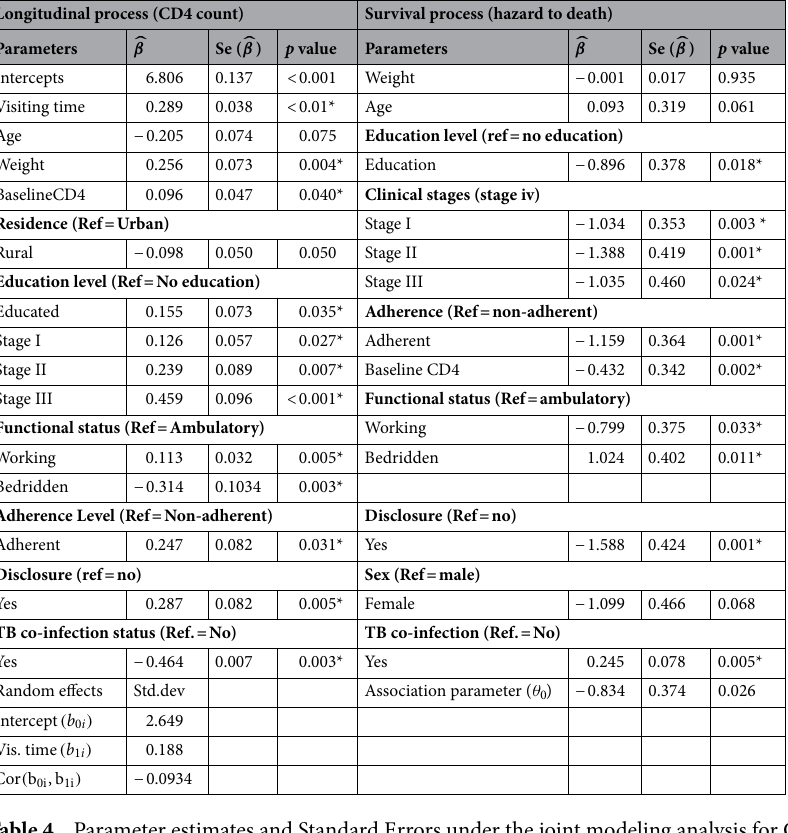
Hence, The rate of hazard for the death of educated family children was decreased by 61.2% (1–0.388)*100 as compared with non-educated family children, keeping the other covariates constant (HR = 0.388, 95% CI (0.185, 0.817), p value = 0.013). As baseline CD4 cell count increased by one cell/mm3, the rate of hazard/risk for death was decreased by 2.1% , keeping the other covariates constant (HR = 0.979, 95% CI 0.743, 0.999), p value = 0.002). The rate of hazard/risk for death of adherent children was decreased by 73.1% as compared to non-adherent patients, given the other covariates constant (HR = 0.269, 95% CI (0.128, 0.579), p value = 0.005). Similarly, the rate of hazard/risk for death of TB-coinfected children was increased by 57.3% as compared to non TB co-infected children, given the other covariates constant (HR = 1.573, 95% CI (1.353, 1.877), p value = 0.005). The rate of risk for death of HIV positive children whose WHO stage I was decreased by 61.2% as compared to those of HIV positive children whose WHO stage IV given the other covariates constant (HR = 0.383, 95% CI (0.188, 0.777), p value = 0.008). The rate of risk for death of HIV positive children with WHO stage II was decreased by 74.6% as compared to HIV positive children with WHO stage IV given the other covariates constant (HR = 0.254, 95% CI (0.111, 0.579), p value = 0.001). The rate of risk for death of HIV-positive children with working functional status was decreased by 67.5% as compared to ambulatory children (HR = 0.325, 95% CI (0.146, 0.719), p value = 0.006). On the other hand, the rate of risk for death of bedridden children was increased by 10.9% as compared to bedridden children, given the other covariates constant (HR = 1.1085, 95% CI (1.2344, 1. 8120), p value = 0.008). The rate of risk for death of children whose disease was disclosed by their parent was decreased by 76.2% as compared to those children whose disease was not disclosed, given the other covariates constant(HR = 0.248, 95% CI (0.106, 0.579), p value = 0.001). Finally, the rate of risk for death of HIV/TB co-infected children was increased by 57.3% as compared to non- con-infected children, given the other covariates constant(HR = 1.573, 95% CI (1.353, 1. 877), p value = 0.005). The potential joint predictors of CD4 count and risk for death in Table 4 revealed that baseline CD4 cell count, level of education, functional status of patients, and adherence level of prescribed medication significantly affected CD4 count and risk for death. The estimate of the association parameter ( ) in the survival sub-model under joint analysis was significantly different from zero and this leads to evidence of the association between the two outcomes. As baseline CD4 cell count of patients increased by one cell/mm3, the expected number of CD4 count was also increased by 0.0958 ( p value = 0.0404) but the rate of risk for death of such patients was decreased by 0.4321( p value = 0.0021) keeping the other variables constant.